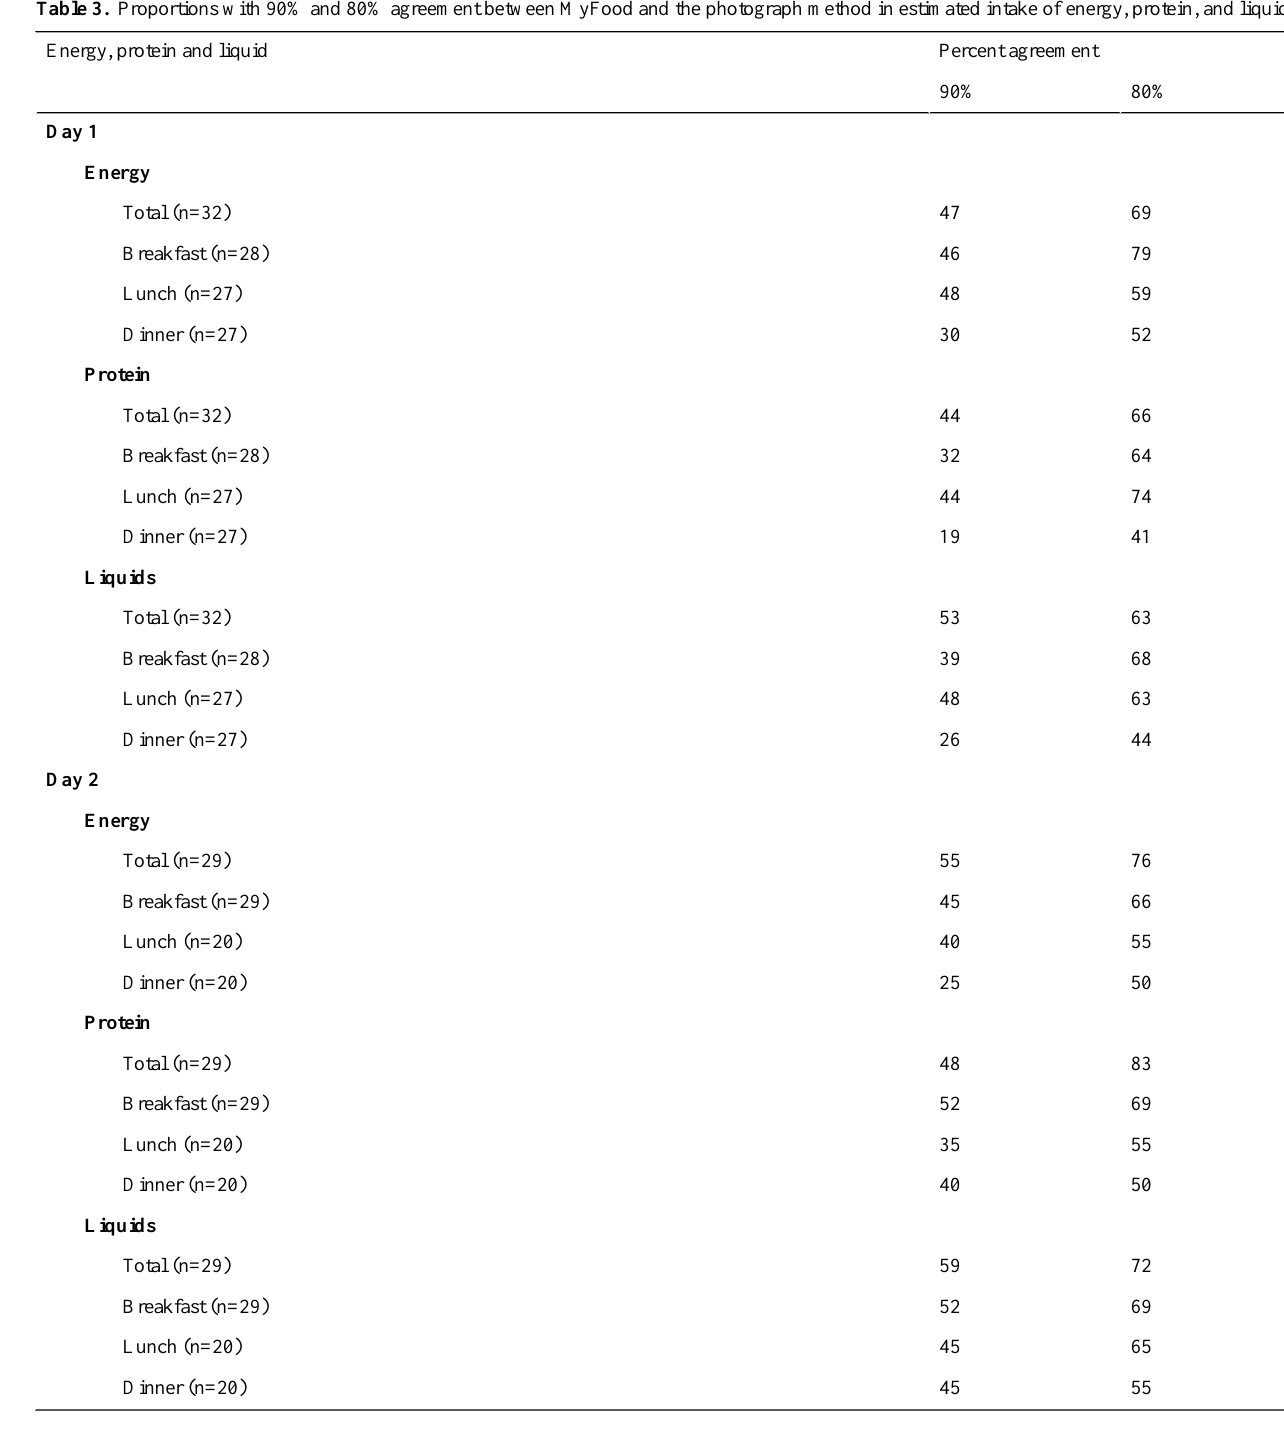
Table 3. Proportions with 90% and 80% agreement between MyFood and the photograph method in estimated intake of energy, protein, and liquids.